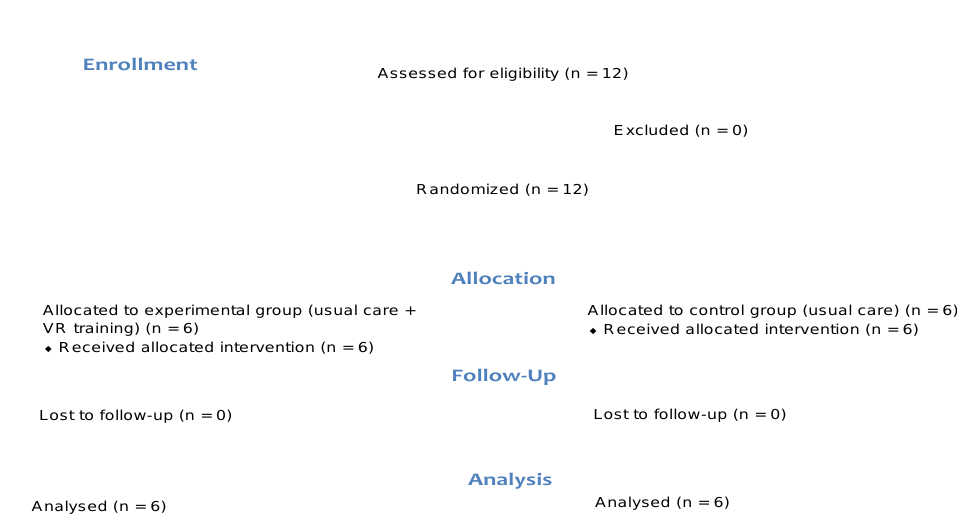
Figure 1. Study design: CONSORT 2010 flow